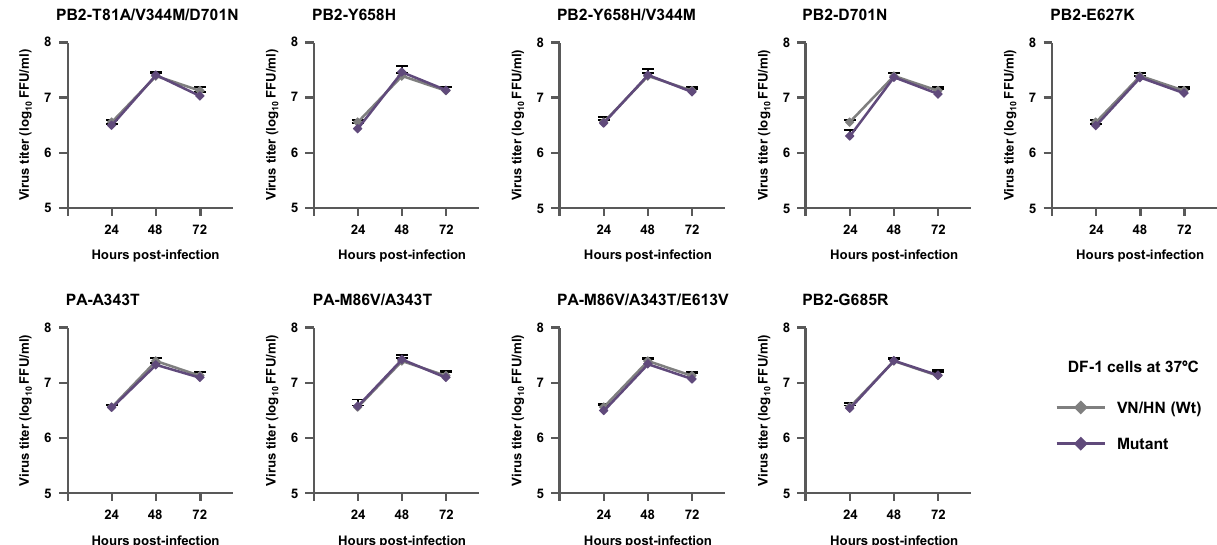
Figure 5. Effect of H5N1 polymerase mutations on viral growth in avian cells. DF-1 cells were infected with the indicated VN/HN viruses at an MOI of 0.01 and incubated at 37 °C. The culture supernatants were harvested at the indicated times and assayed for focus-forming units to determine the progeny virus titers. Each data point is the mean ± SD of the log 10 FFU/ml from three separate